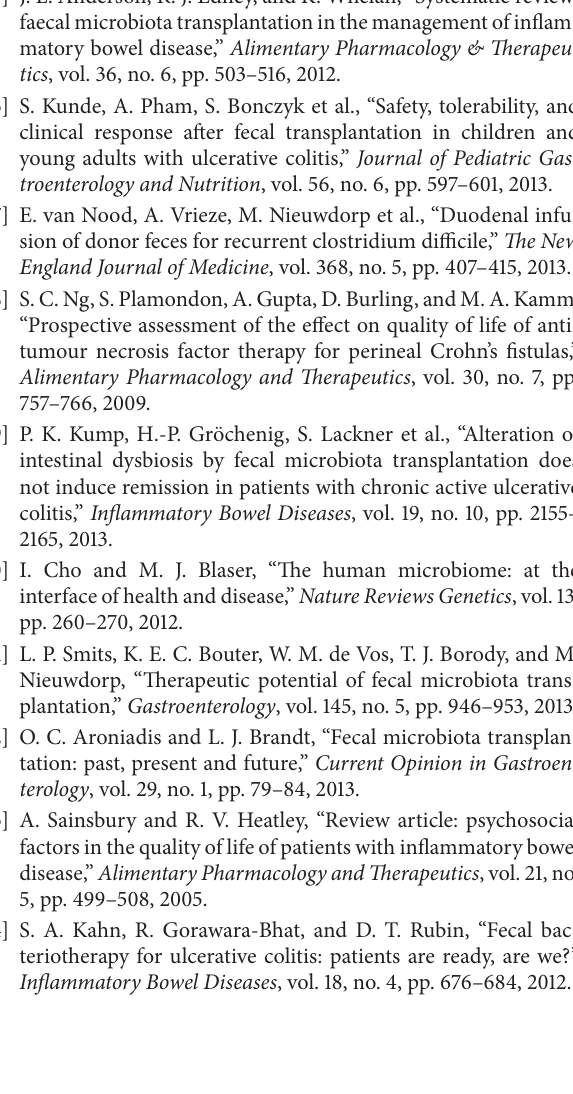
IBDQ: Inflammatory Bowel Disease